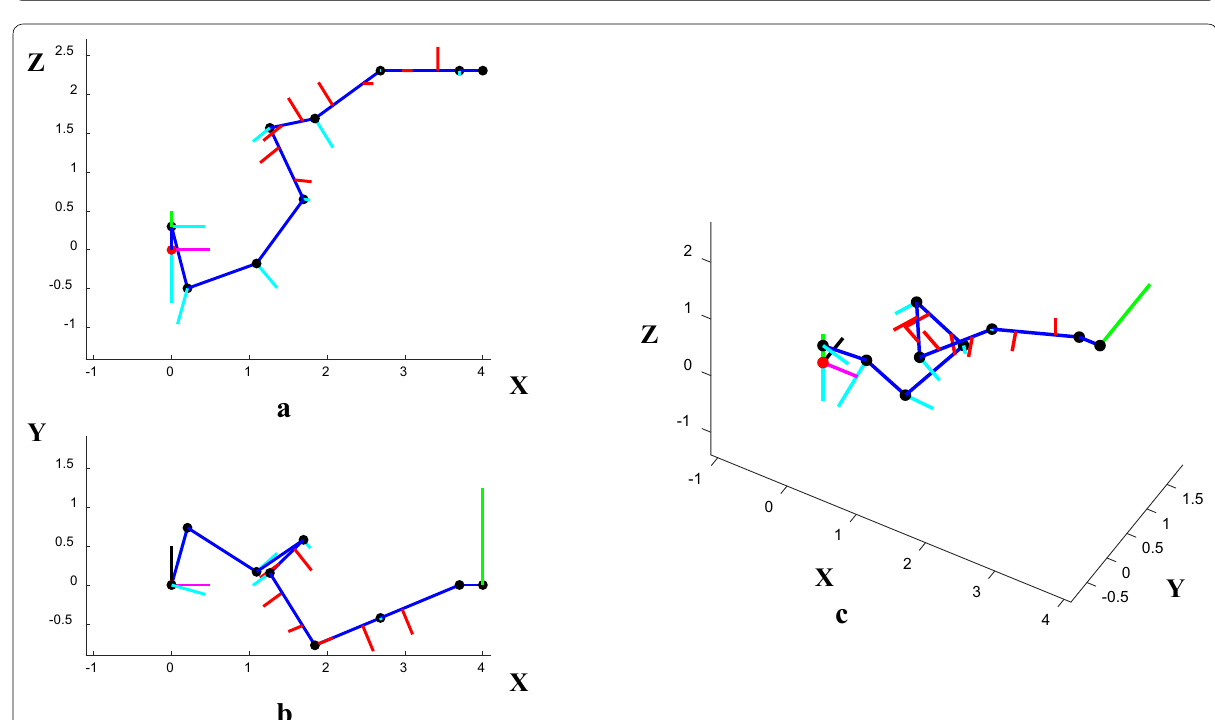
Fig. 10 The simulation arm and flying watch thrusts under the first level watch-actuator cooperation when the external reaction force on the end effector is [0,125,0] N (reduction rate 20.6%). a Front view. b Top view. c 3-D view = −